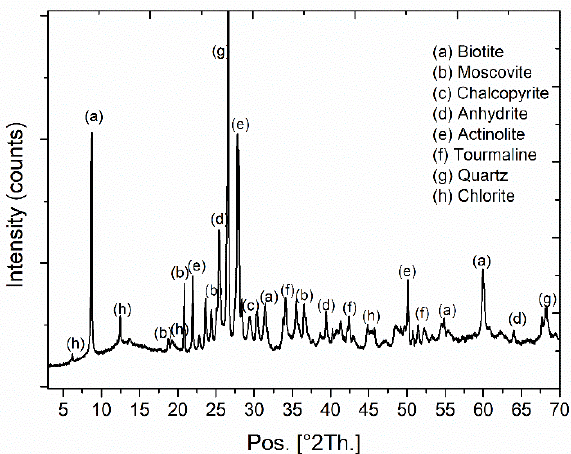
Figure 2. X-ray diffractograms and the main mineral component of ore samples. Samples of 7 kg were used, having a size-# 6 (3.360 um). Samples were heated in a